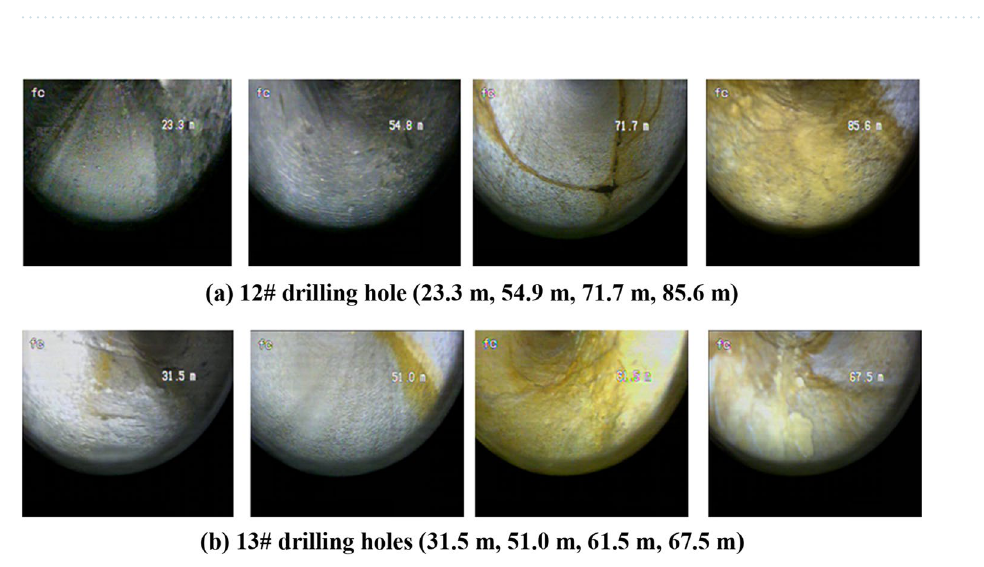
Table 3. Single liquid cement slurry preparation table.